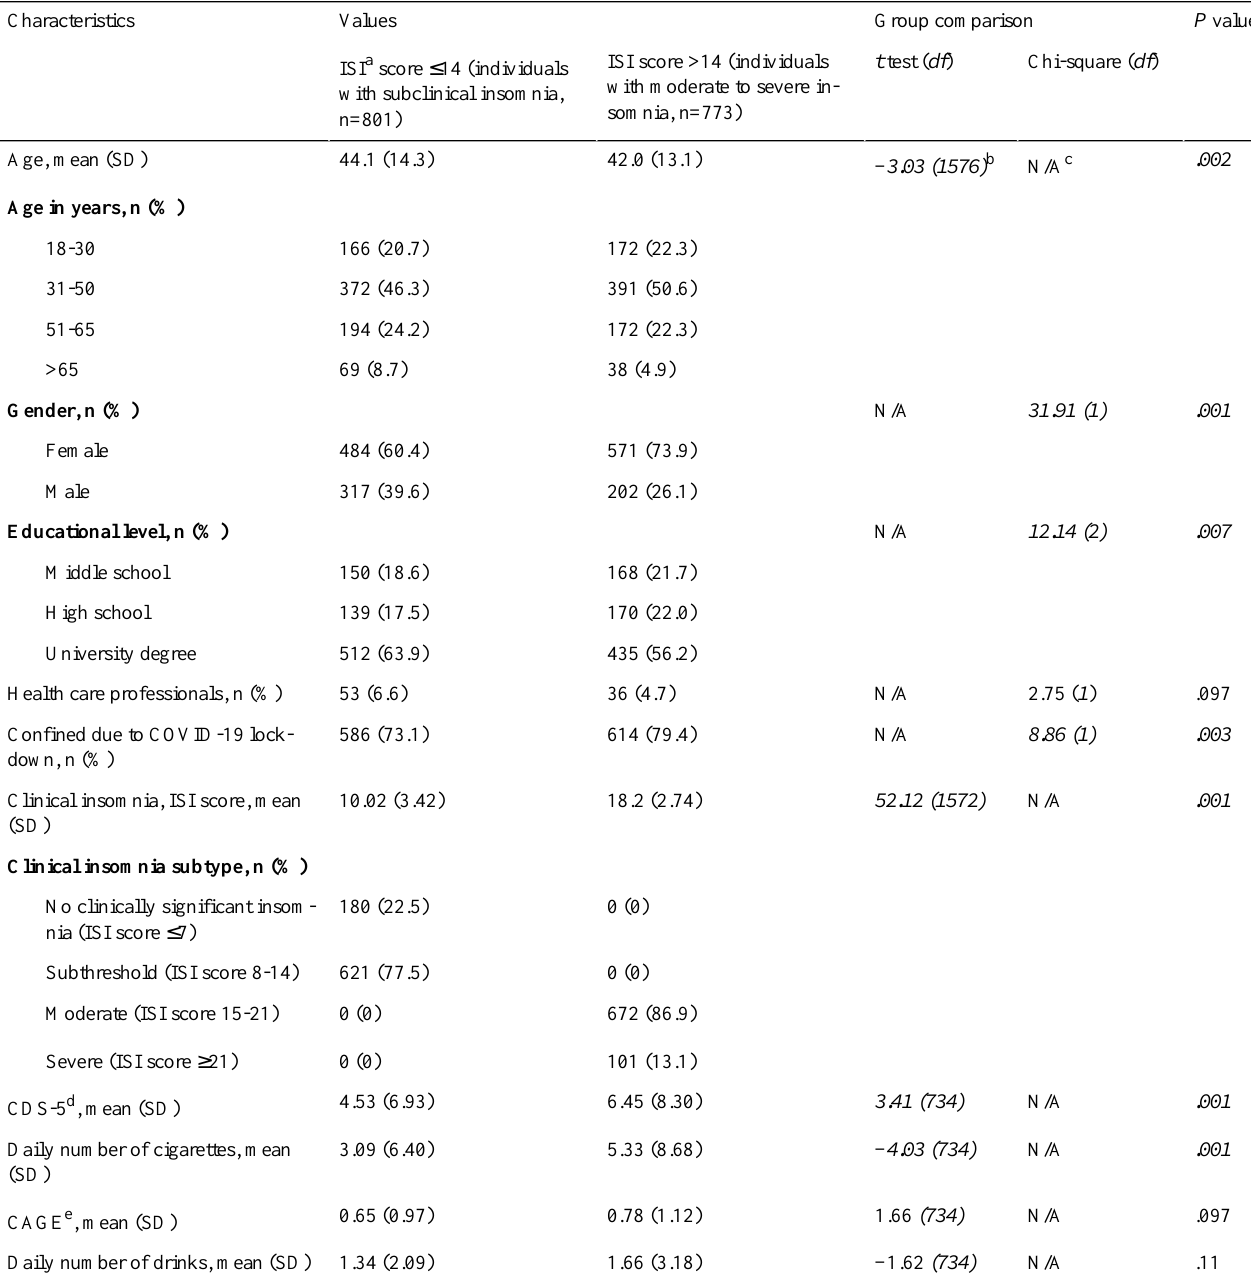
Table 2. Characteristics of users depending on their sleep complaints.